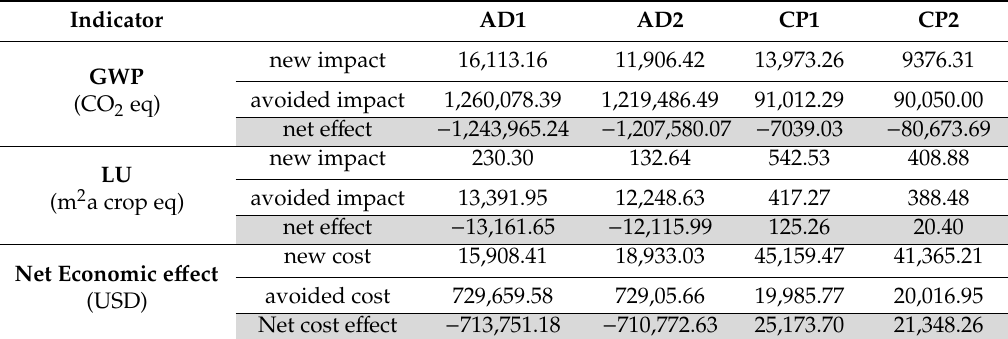
Table 6. Net e ff ect of FW valorization alternatives for GWP, LU and Economic e ff